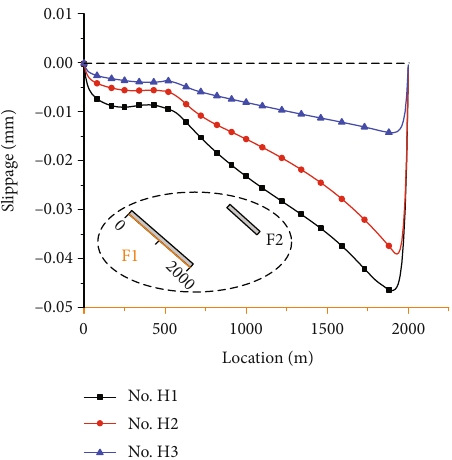
Figure 11: The fault slippage of F1 according to di ff erent fracturing regions (Nos. H1-H3).